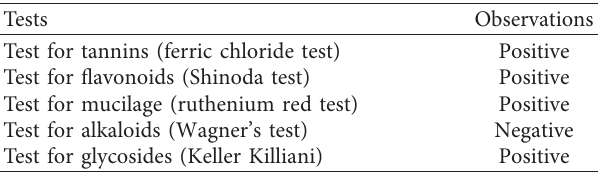
Table 2: Preliminary phytochemical screening of Aloe weloensis